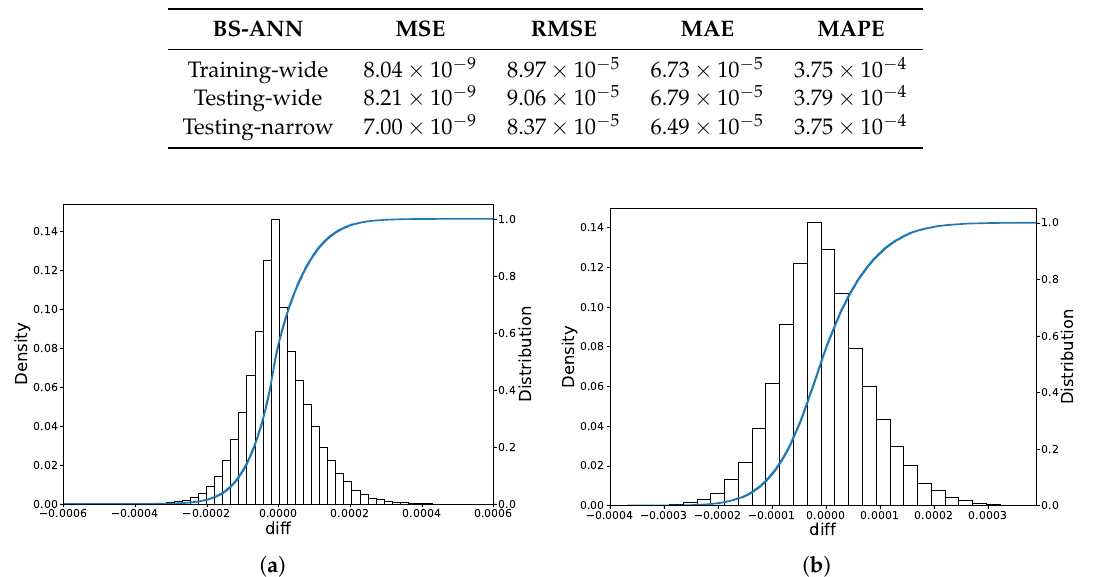
Figure 7. BS-ANN performance. ( a ) Error distribution on the wide test data set; ( b ) Error distribution on the narrow test data